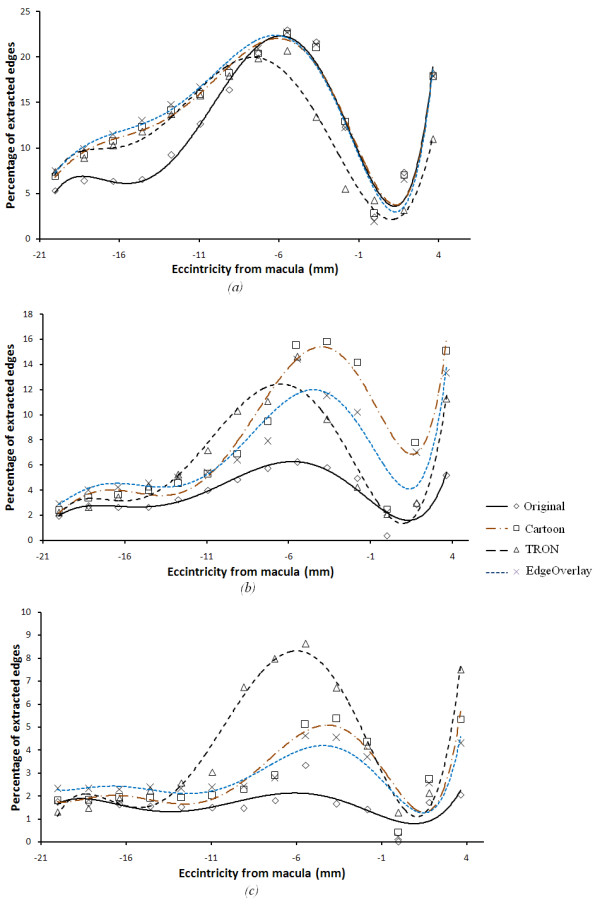
Efficacy of enhancement algorithms on the simulated pelli Robson's images at different object contrasts. (a-c) The efficacy of each algorithm compared to the original image on an image with object of 2.26, 1.66 and 0.75 contrasts, respectively, based on the Pelli Robson's method with respect to the eccentricity from the macula.